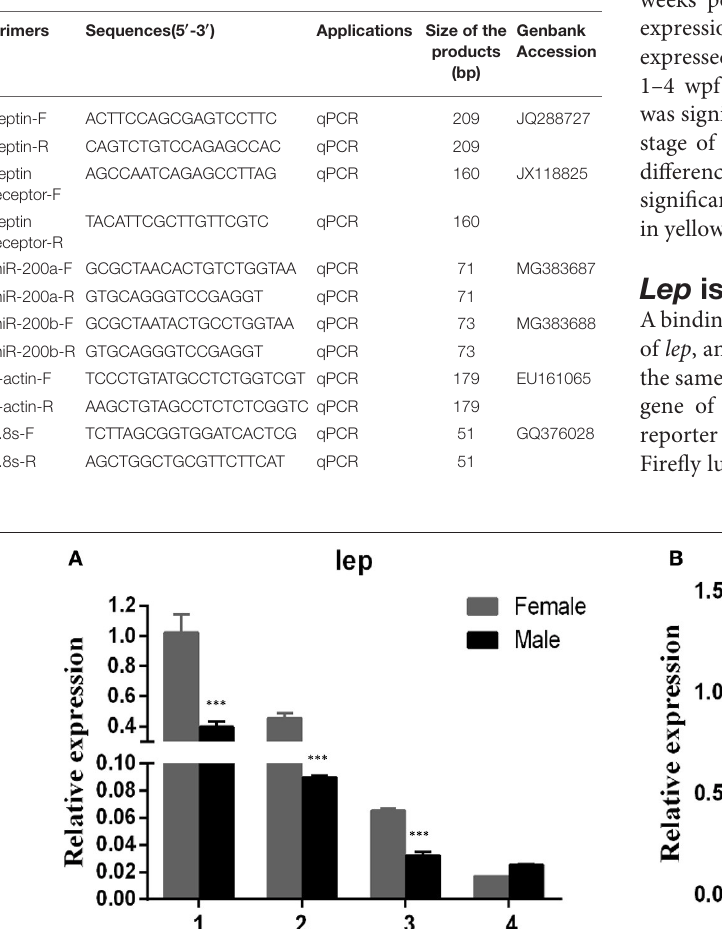
TABLE 1 | The primers for qRT-PCR.